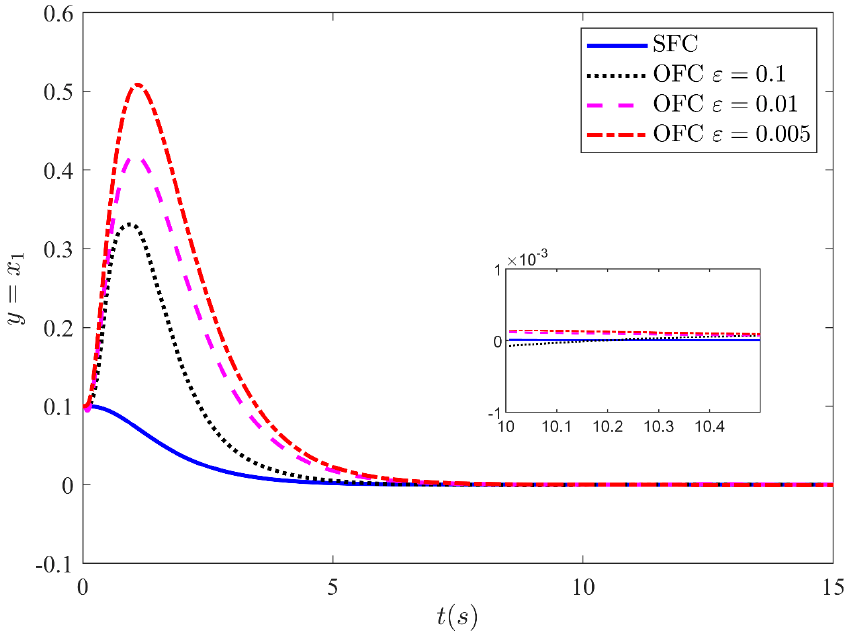
Figure 8. Stabilizing performance of the CL system under SFC and OFC with SMC based HGO without input saturation for three different values of ε = 0.1, ε = 0.01, and ε = 0.005.